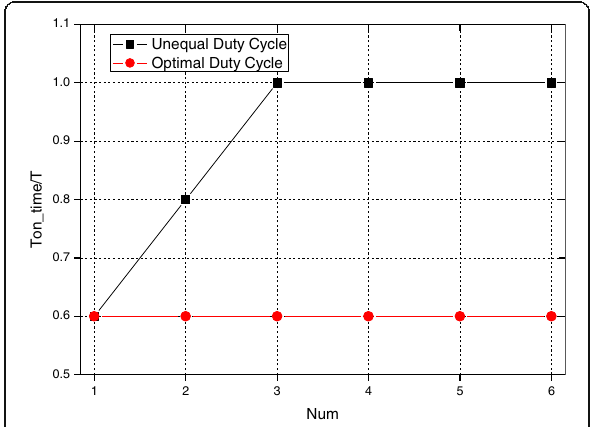
Fig. 22 The duty cycle used at each node in linear network